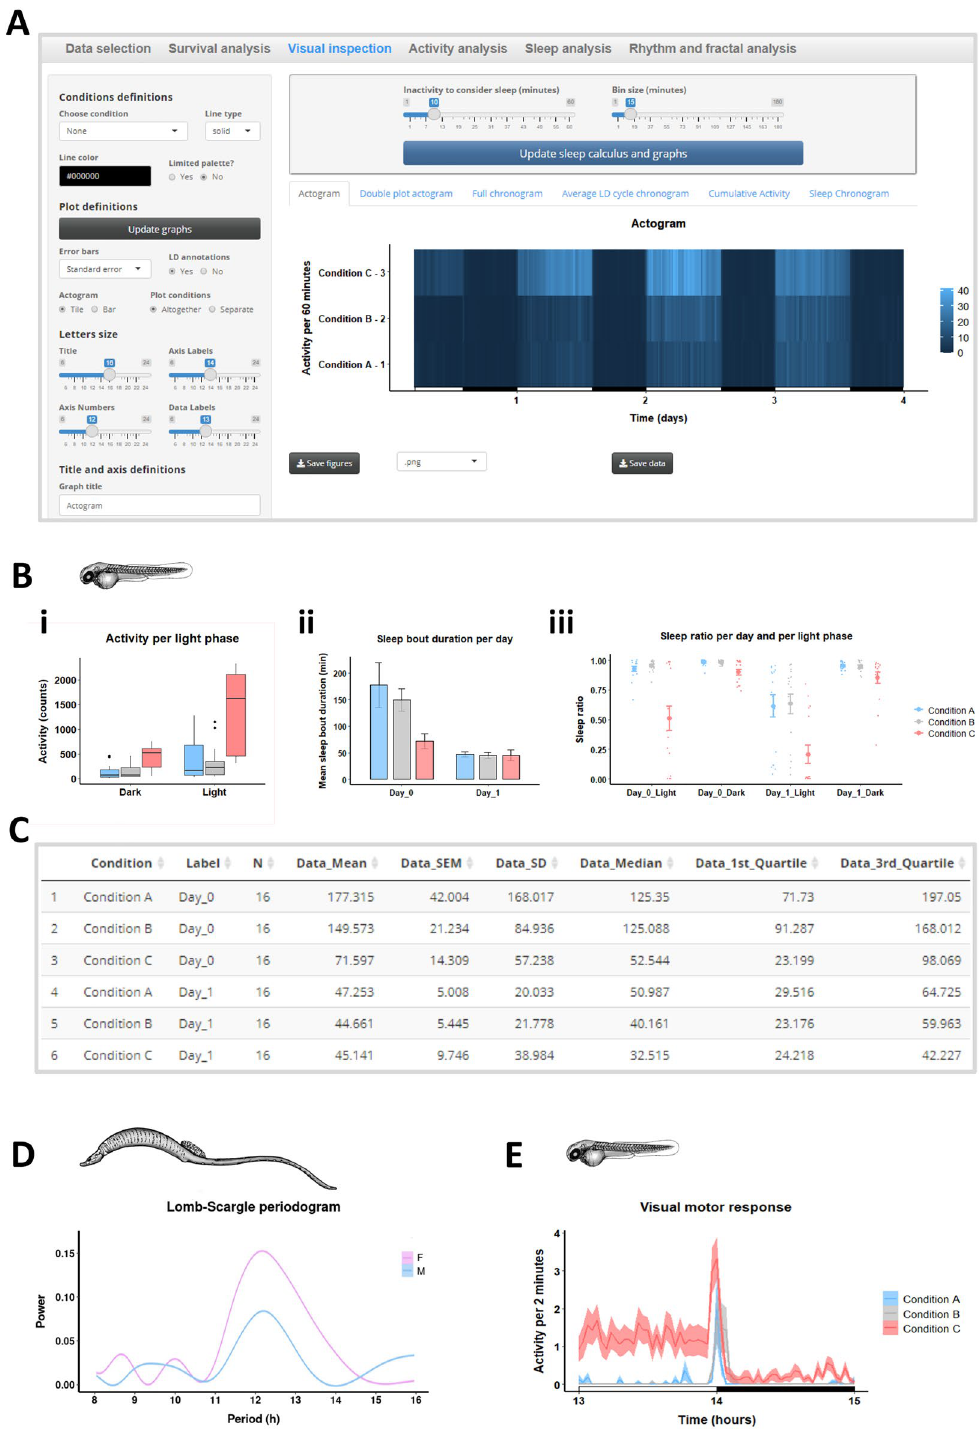
Figure 3. Versatility of data visualization and analysis. ( A) Visual inspection: partial display of user inputs to customise publication- ready graphs. The actogram represents activity per 15 min with light and dark annotations (x axis). ( B) Representation of activity per light phase (i), sleep bout duration per day (ii), and sleep ratio per day and light phase (iii); in box-plots (i), bar-plots (ii), and dot-plots (iii). Data are from individual zebrafish larvae (time 0 equals 4 dpf). ( C) Descriptive statistics of the sleep bout duration per day (Bii). For each condition, the table includes the number of animals, mean, errors (SEM; SD), median, and other quartiles (Q1, Q3). ( D) Lomb-Scargle periodogram of intertidal pipefish activity (adult Nerophis lumbriciformis ), showing circatidal rhythmicity (12.4 h) for females and males (F, M). ( E) Representative chronogram showing ‘visual motor responses’ evoked by sudden light-to-dark-transition in zebrafish (4 dpf). Zebrafish data were obtained with LAM10 (Trikinetics). Pipefish data were obtained with video recordings and illustrate the capability of Rtivity to use counts per time data from any source, if they are first converted into the standard monitor file format. Images in Figure contain screenshots of the Rtivity software developed in this study (https:// ruisi lva. shiny apps. io/ rtivi ty/), and drawings by co-author NM of pipefish and zebrafish, assembled and illustrated by co-authors RS, NM, and JMAO using version 2.8.22 of the free image editor GIMP (https:// www. gimp.